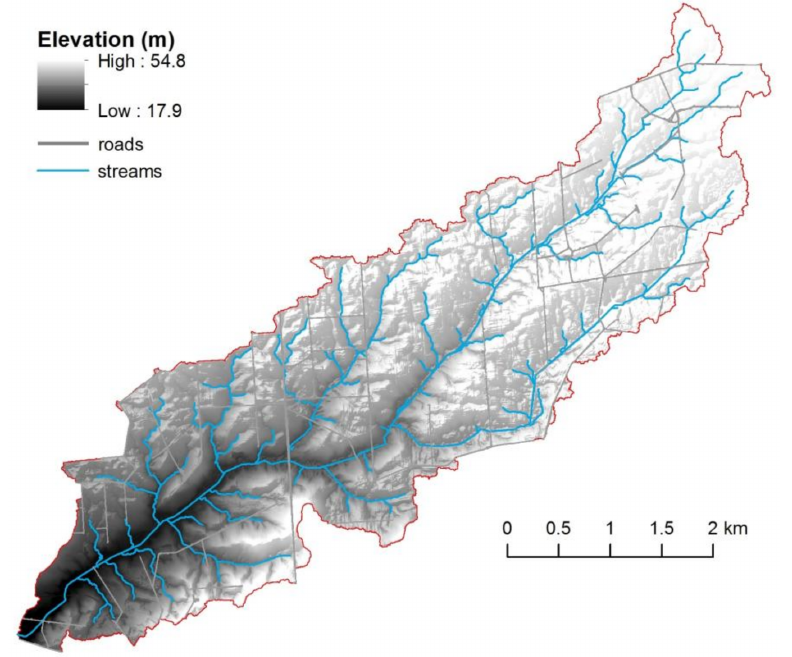
Figure 2. Shaded digital elevation model (DEM) of the study area based on light detection and ranging (LiDAR) data. Roads and streams with a contributing area ≥ 5 ha are also